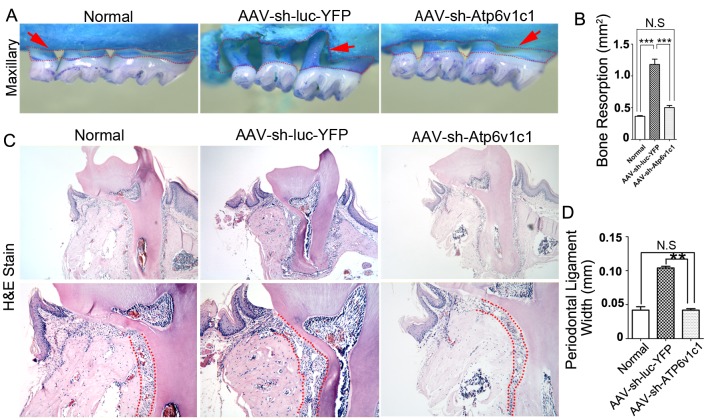
Bone resorption in experimental periodontitis was reduced by Atp6v1c1 knockdown.(A) In the AAV-sh-luc-YFP group with infection, marked bone resorption can be seen and all teeth roots are exposed near the tip of the root in the maxillary (red dotted area). (B) There is almost twice the amount of bone resorption in the AAV-sh-luc-YFP group when compared to the AAV-sh-Atp6v1c1 group. (C) The red dot area shows a widened periodontal ligament area in the AAV-sh-luc-YFP treated disease group. (D) The periodontal ligament width is almost doubled in the AAV-sh-luc-YFP treatment group compared to the AAV-sh-Atp6v1c1 treatment group, indicating that alveolar bone loss was prevented by AAV-sh-Atp6v1c1. **: P<0.01, ***: P<0.001, N.S: No Significance.